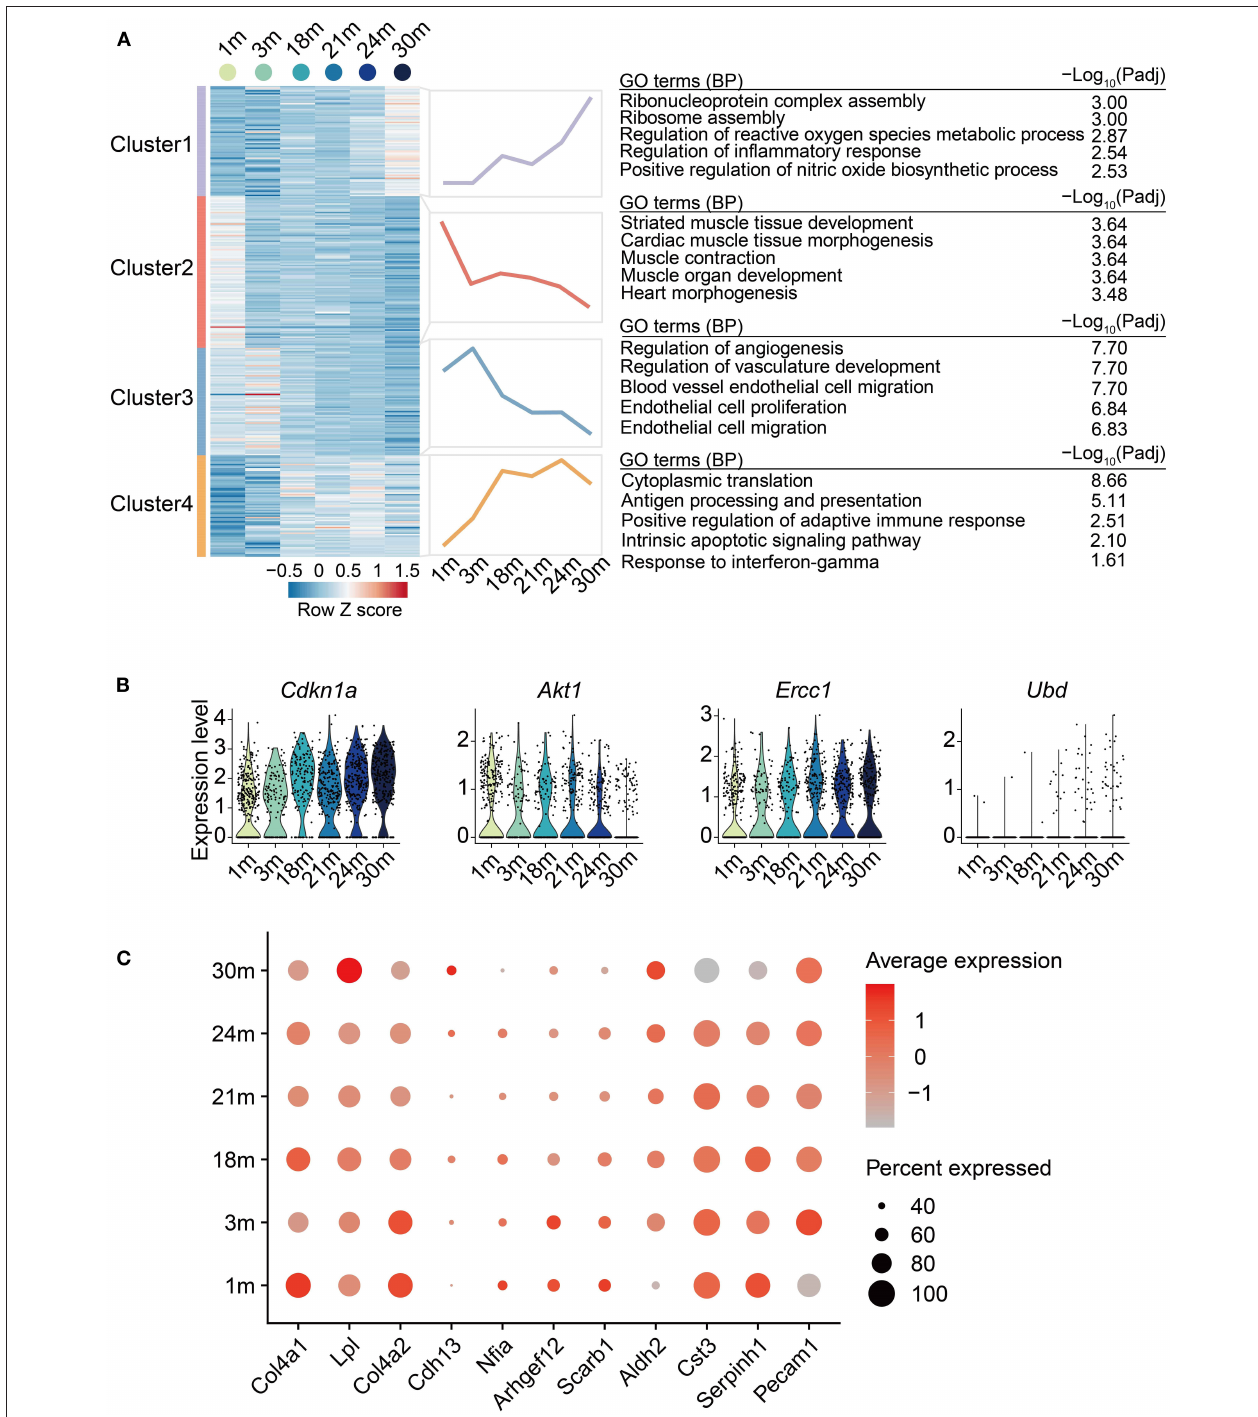
FIGURE 3 | Age-related transcriptional dynamics in cardiovascular ECs. (A) Left: Heatmap showing expression signatures of age-dependent genes (ADGs) of ECs from heart and aorta with age; row-scaled Z scores are indicated by colors from blue (low) to red (high). Middle: Line plots showing average expression value of each cluster. Right: representative GO terms. (B) Violin plots showing the expression level of the overlapped genes between identified ADGs and genes acquired from GenAge database. (C) Dot plot showing the expression level of ADGs associated with cardiovascular diseases.